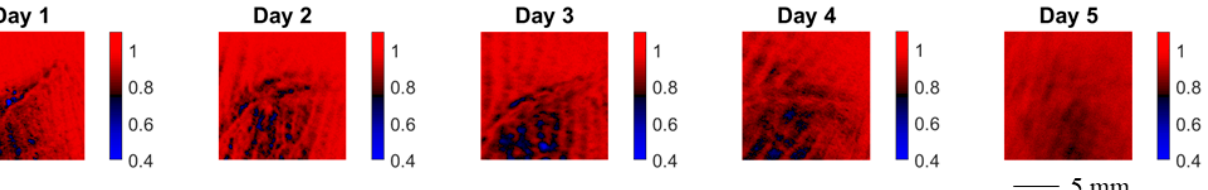
Figure 8. Spatially resolved depolarization power Δ for wound healing monitoring of a cut in a finger. The wound was measured five consecutive days after the cut. The orientation of the wound in the image changes in between measurements.